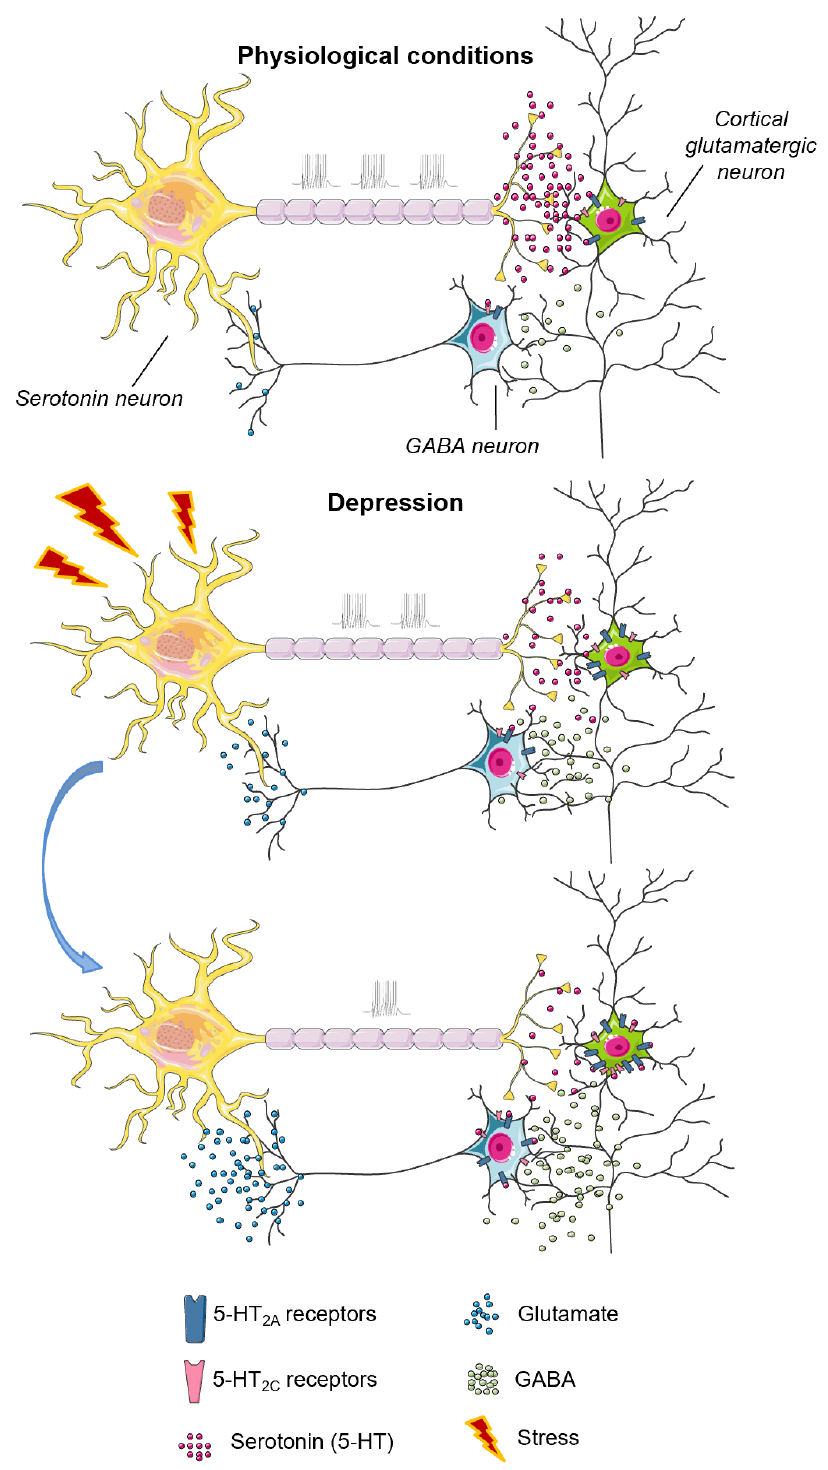
Figure 2. Schematic representation of mechanisms of 5-HT 2A and 5-HT 2C receptor involvement in the pathogenesis of depression. Under physiological conditions, postsynaptic 5-HT 2A and 5-HT 2C receptors regulate glutamate and/or GABA release; upon stress-induced serotonin depletion, 5-HT 2A and 5-HT 2C receptors are upregulated and sensitized. Sensitized 5-HT 2A and 5-HT 2C receptors indirectly inhibit serotonergic neurotransmission, aggravate serotonin deficit and provoke depressive- like